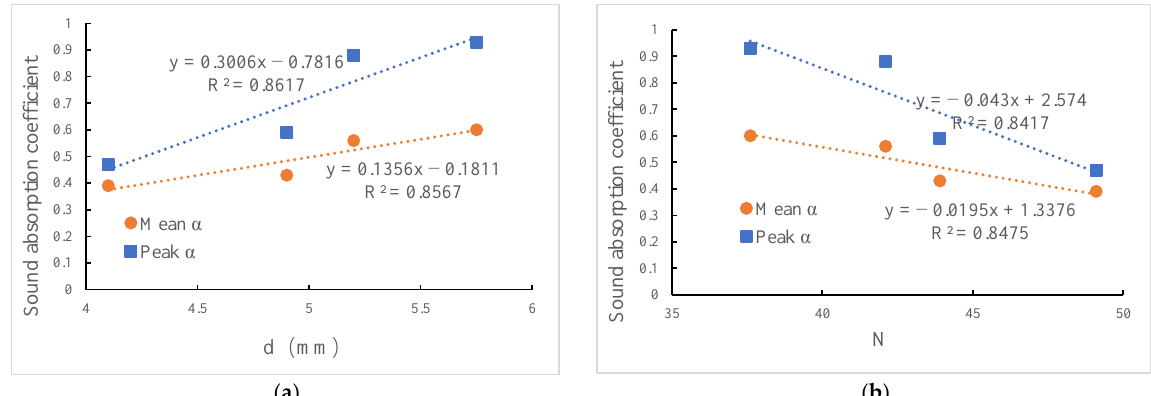
Figure 6. The relationship between the SAC and the parameters of size and number: ( a ) Relationship between SAC and 𝑁 ; ( b ) Relationship between SAC and 𝑑 .